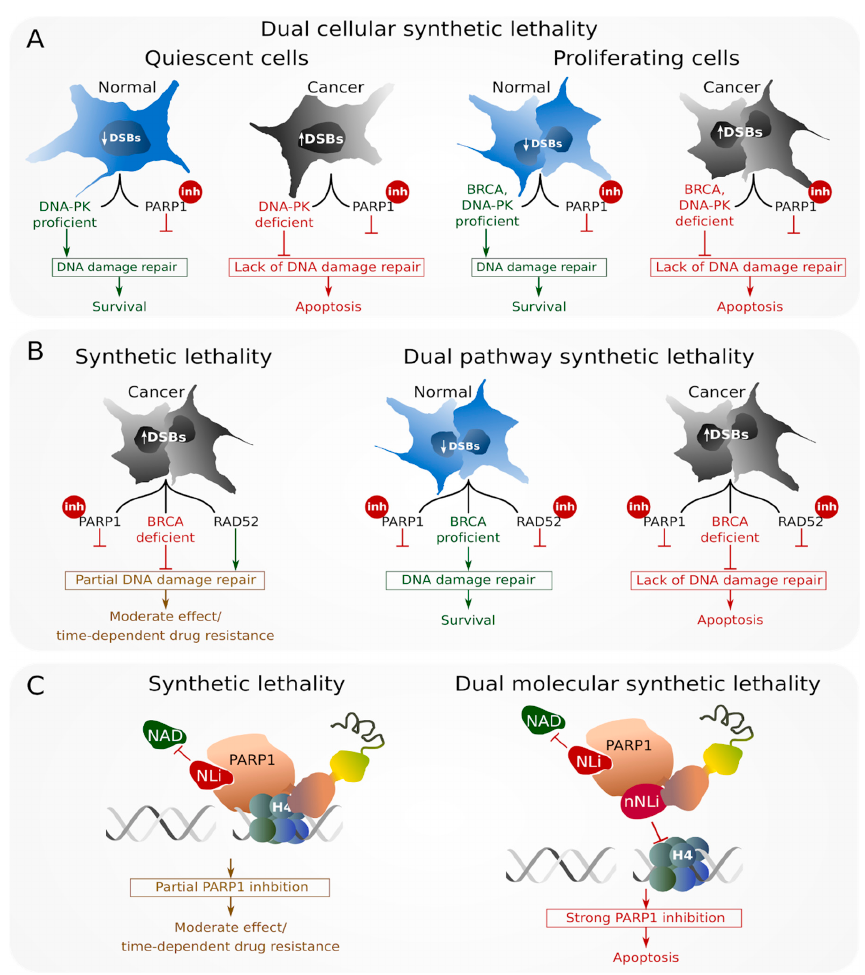
Figure 3. Dual synthetic lethality strategies: ( A ) Dual cellular synthetic lethality—inhibition (inh)